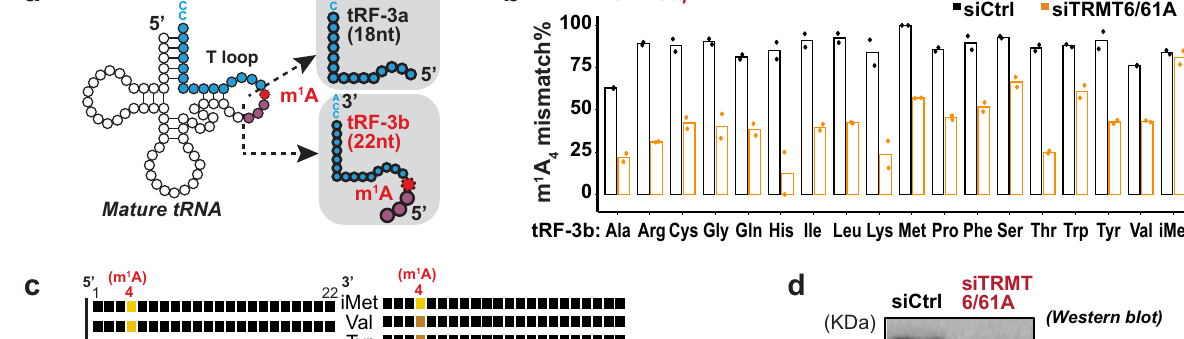
only used TGIRT mismatch signature to quantify m 1 A at speci fi c sites for the following analysis.